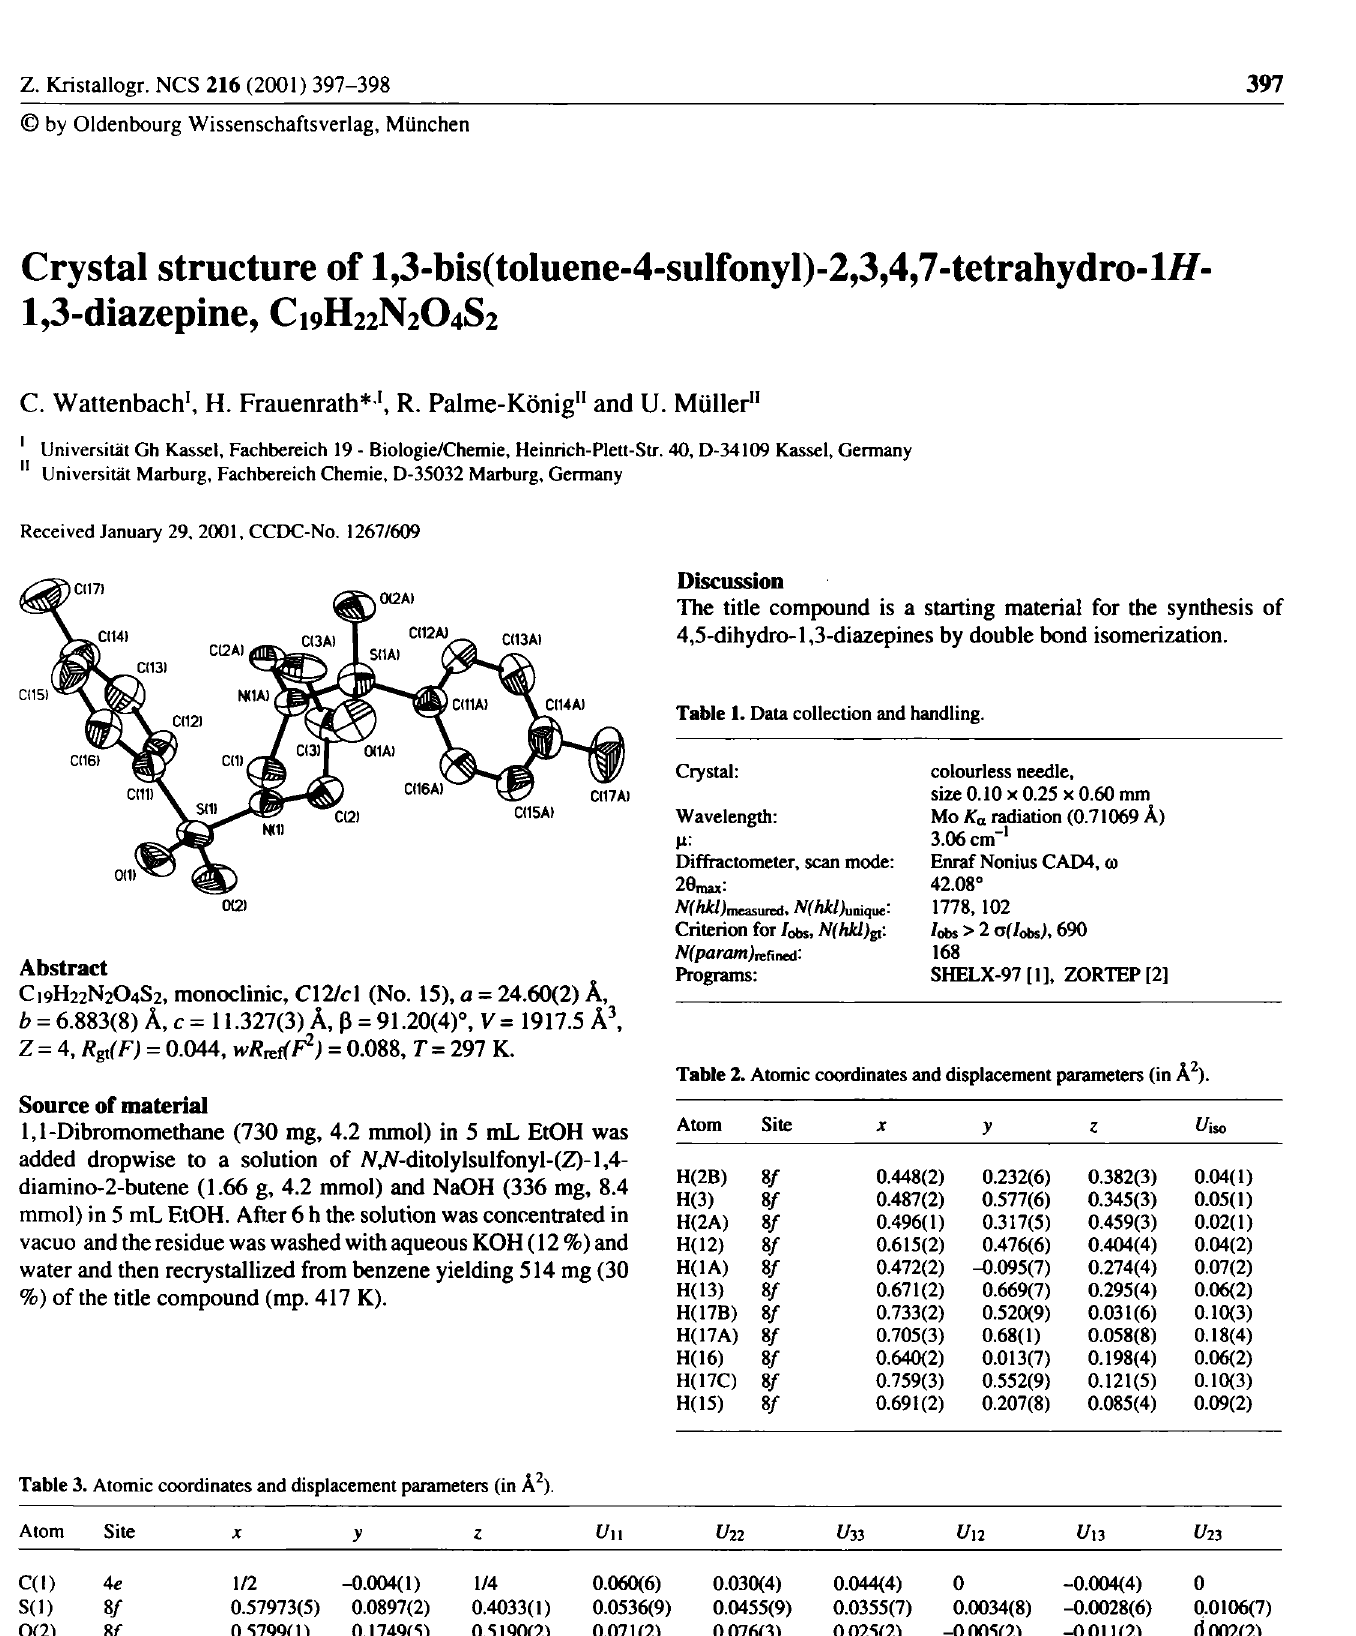
Table 3. Atomic coordinates and displacement parameters (in A 2